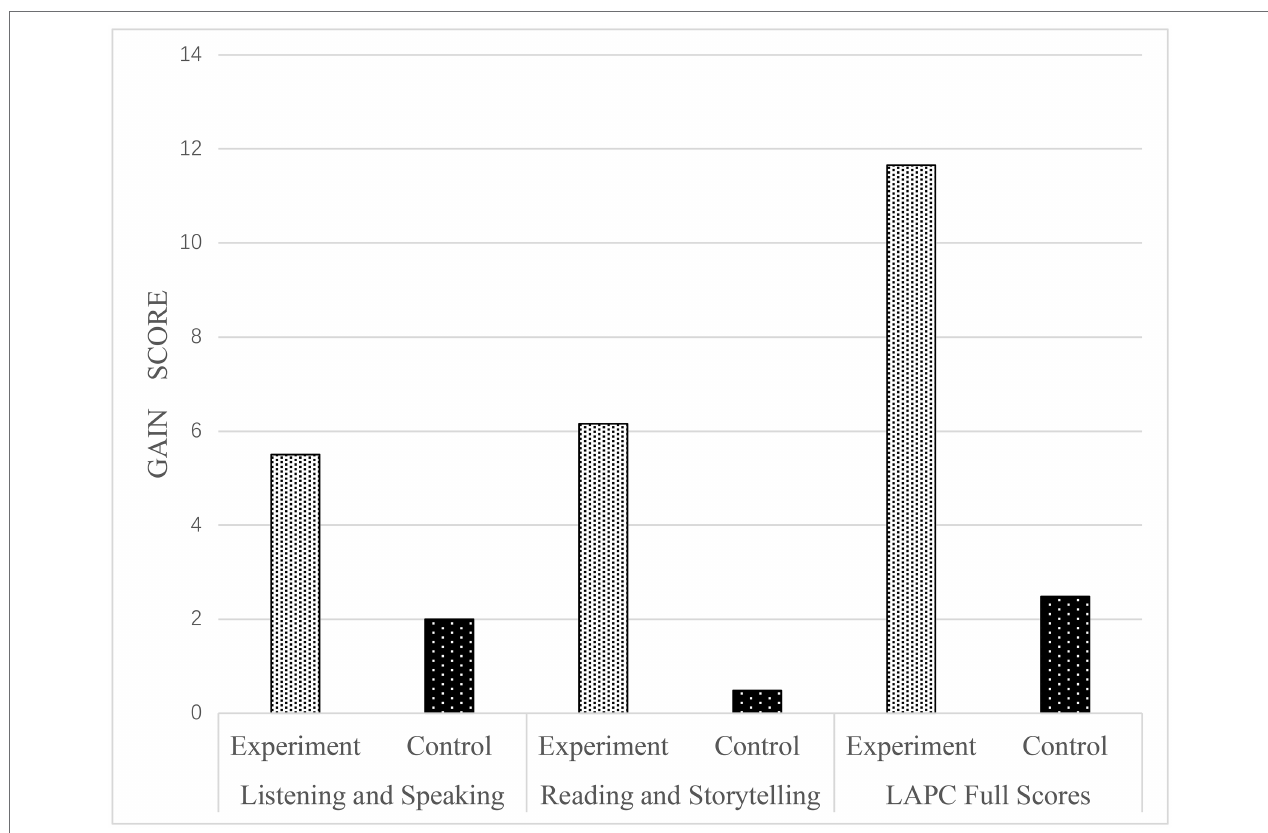
FIGURE 1 | Comparison of gain scores in the LAPC tasks between the experiment and control groups. Experiment group: n = 32; Control group: n =